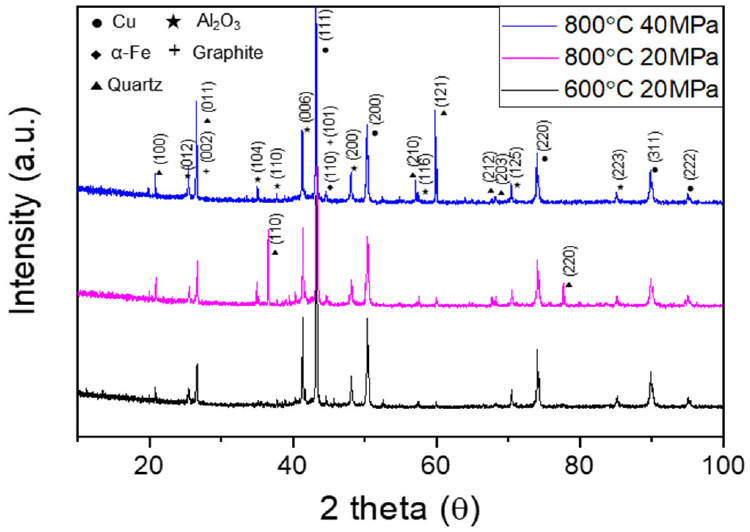
Figure 4. X-ray diffraction (XRD) spectra of surfaces of Cu-based brake pads fabricated under different conditions.